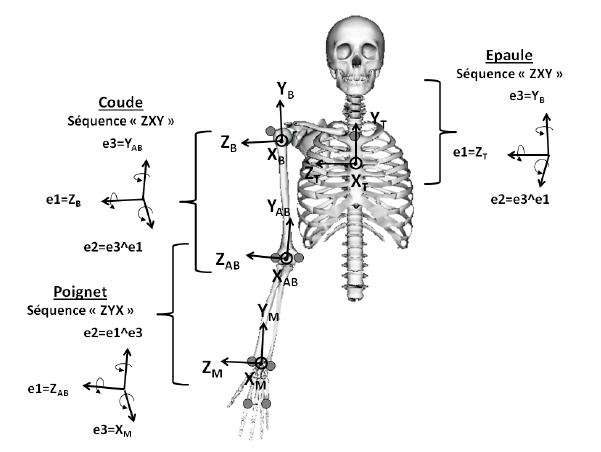
Figure 2. The adopted biomechanical